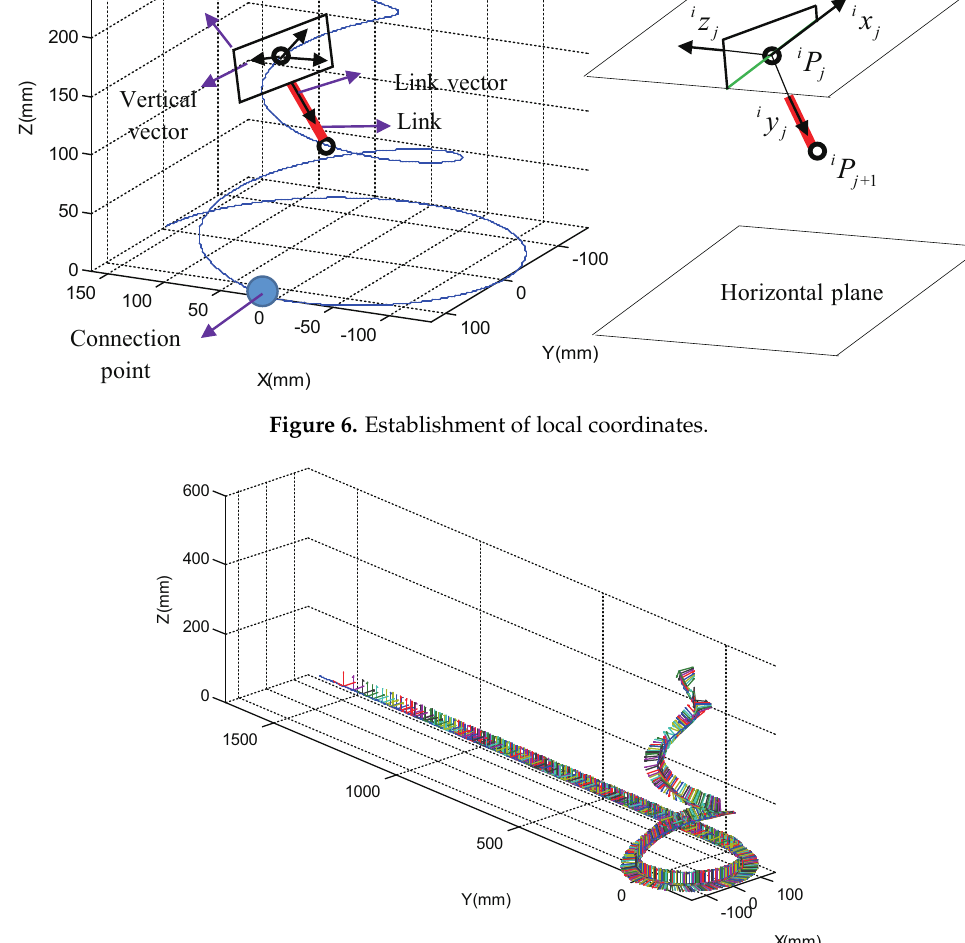
Figure 7. Local coordinates during entire head-raising